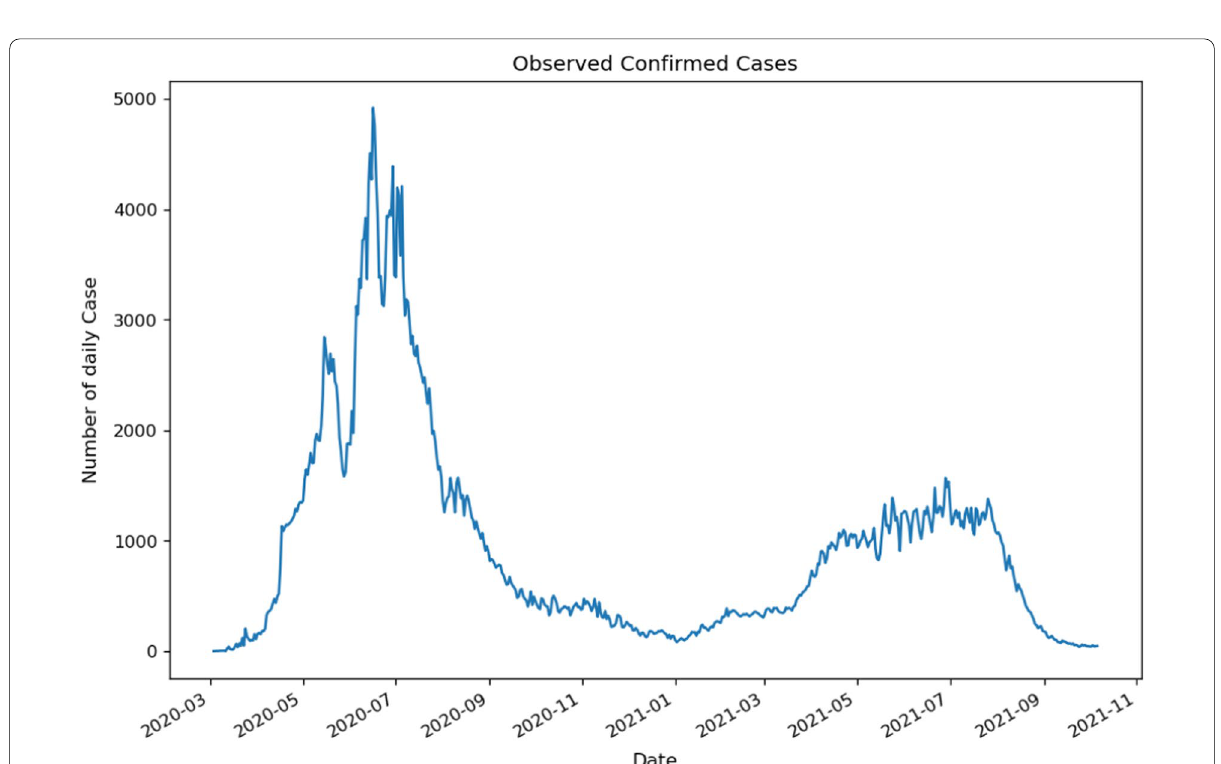
Fig. 1 Sequence chart of new series of COVID-19 confirmed cases